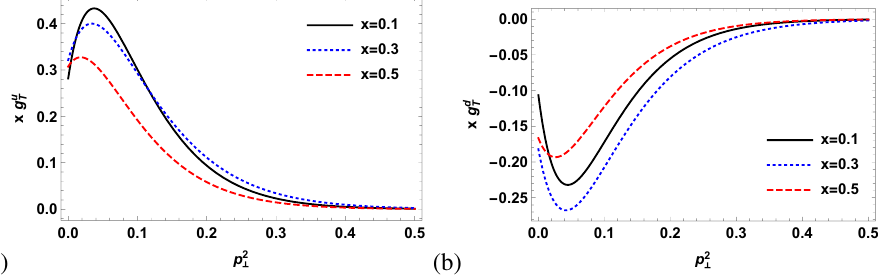
Figure 2: (Color online) The transversely polarized TMD x g ν to p 2 at di ff erent values of x . The left and right column correspond to up and do w n quarks ⊥